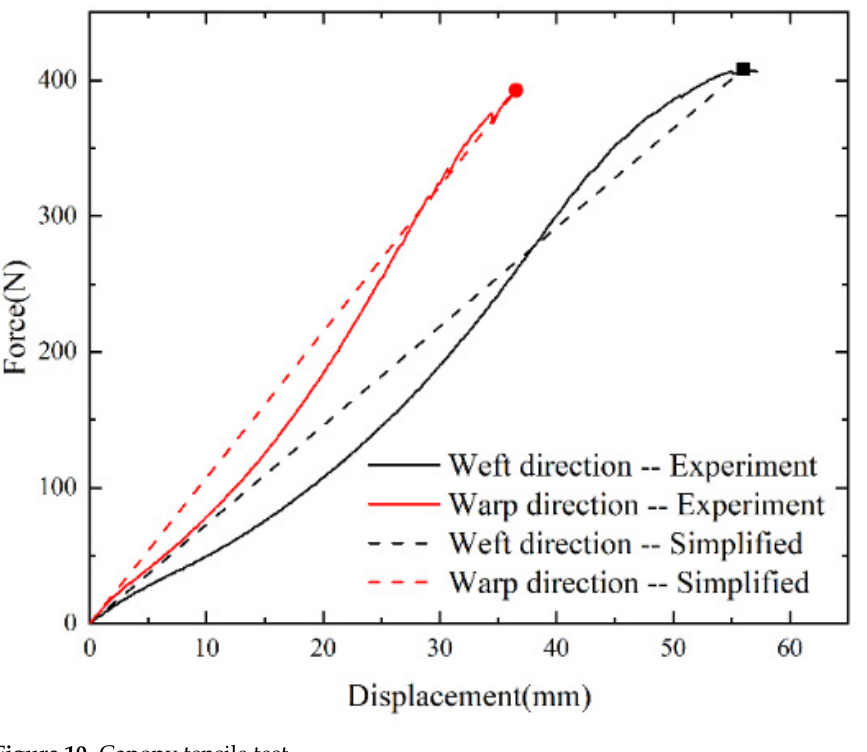
Figure 10. Canopy tensile test.